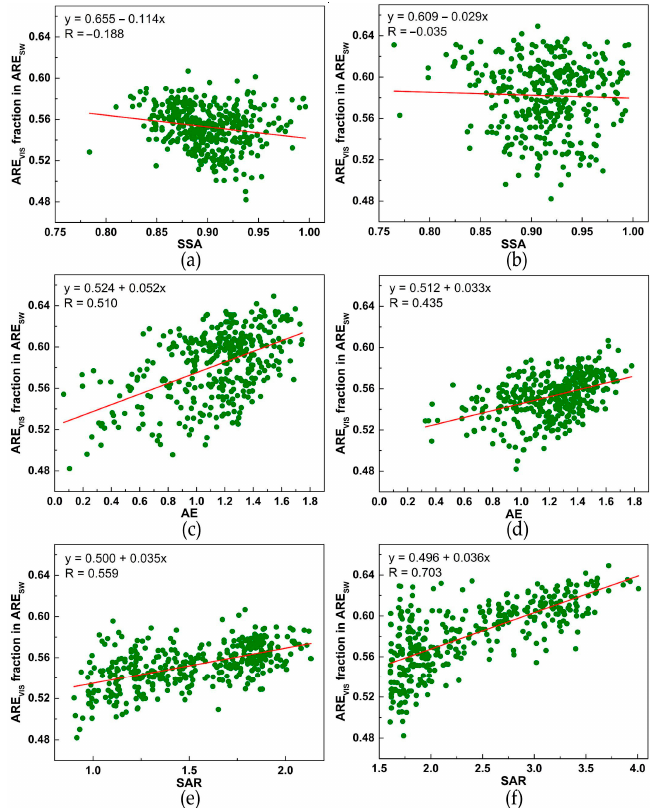
Figure 15. Dependence of REE on SSA in ( a ) Wuhan and ( b ) Dengfeng, AE in ( c ) Wuhan and ( d ) Dengfeng, and SAR in ( e ) Wuhan and ( f ) Dengfeng.